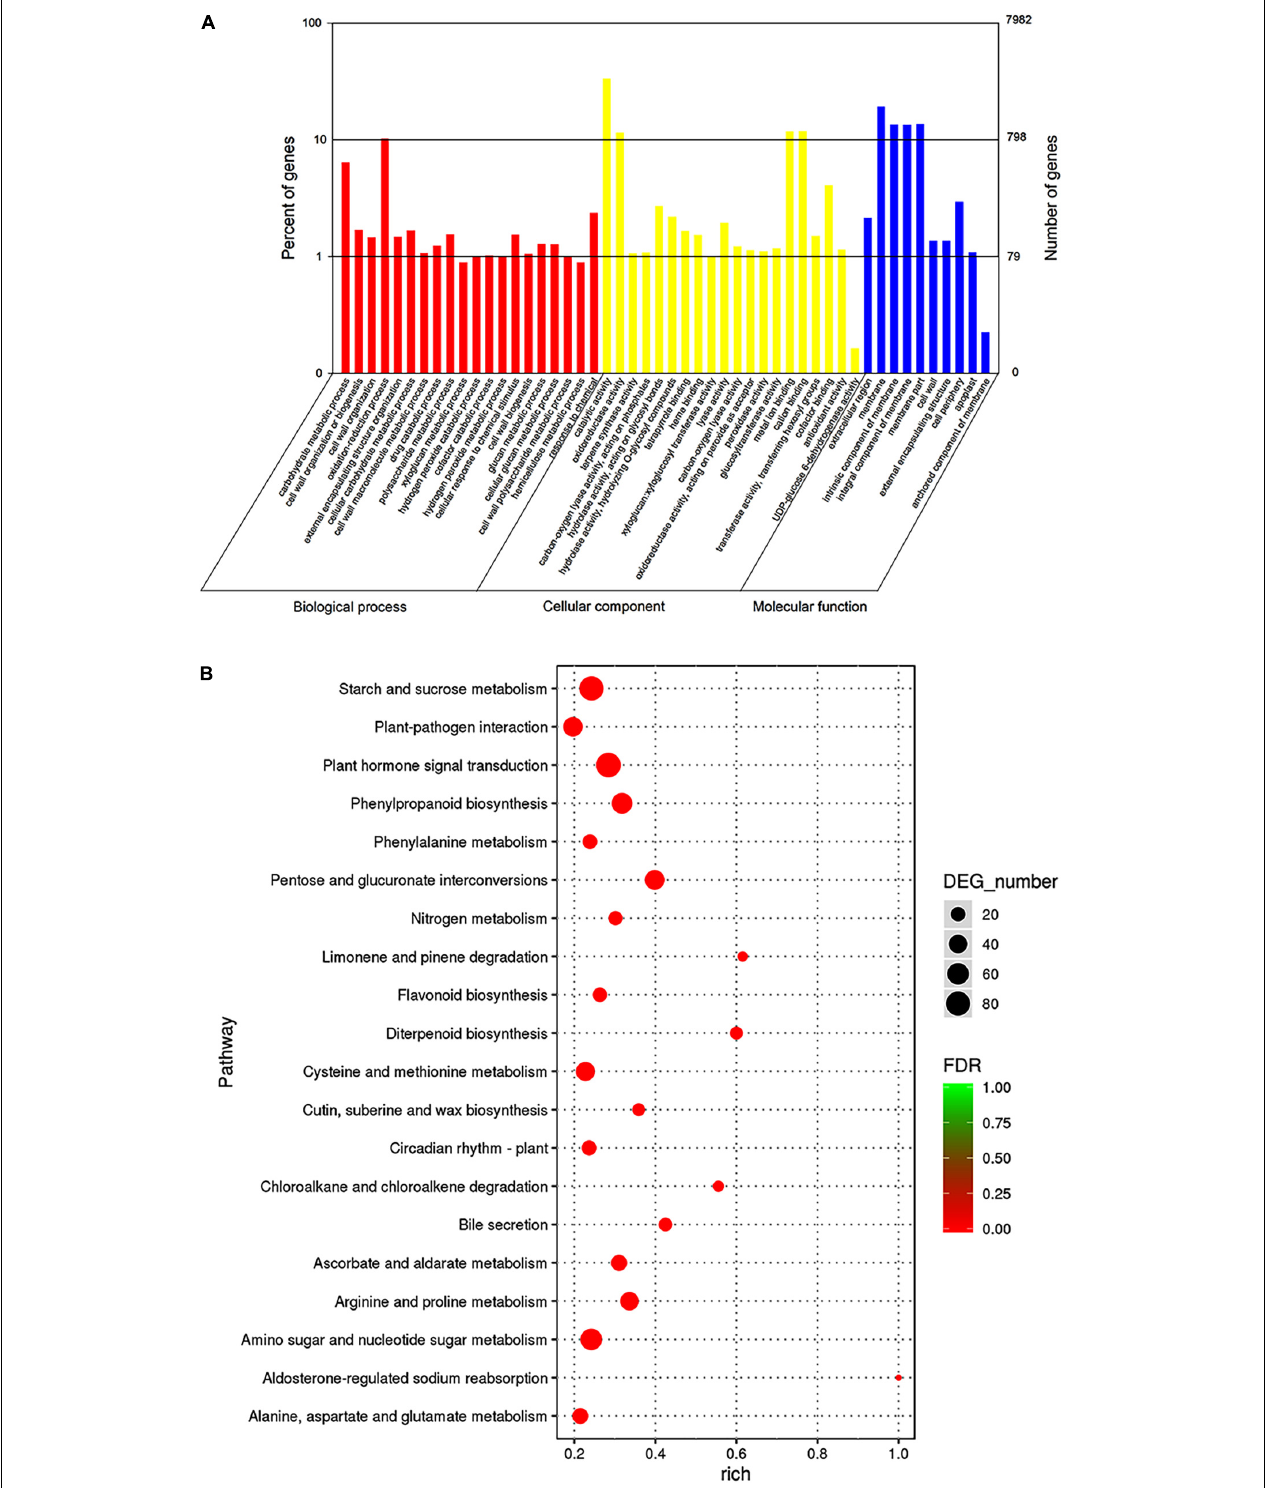
FIGURE 4 | Gene ontologies classification (A) and KEGG enrichment (B) of DEGs between 96 and 141 DASP at the transcript level. (A) GO classifications, the x -axis indicates the GO term, and the y -axis indicates the number of DEGs. (B) KEGG enrichment, the dot size indicates the number of DEGs in certain pathways. A larger size represents more DEGs. The color shade of the point represents the change in false discovery rate (FDR). A smaller FDR indicates more statistical significance. N = 3.